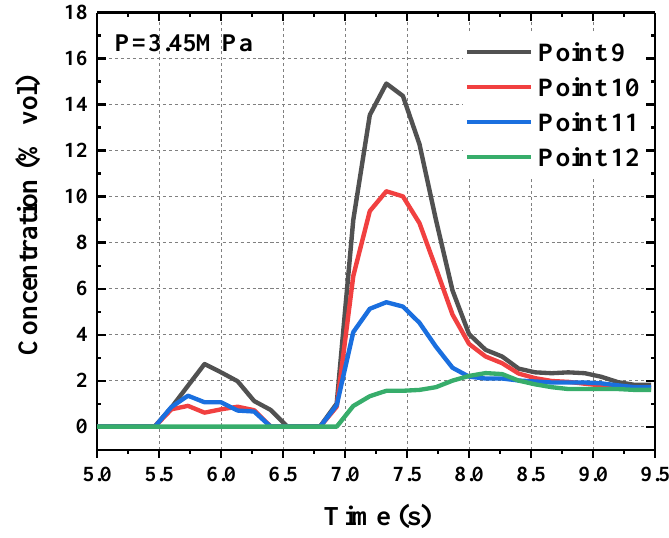
Figure 14. Concentration versus time at points 9, 10, 11, and 12 in Section III in the case of 3.45